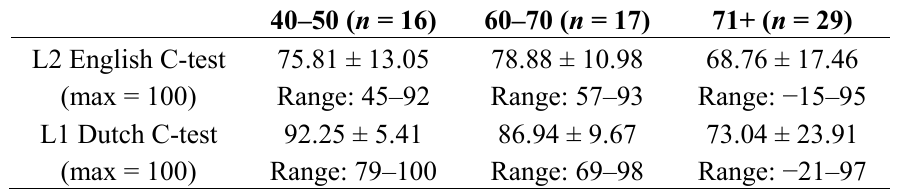
Table 2. Mean scores (and SDs) on the English and Dutch C-test, split per age